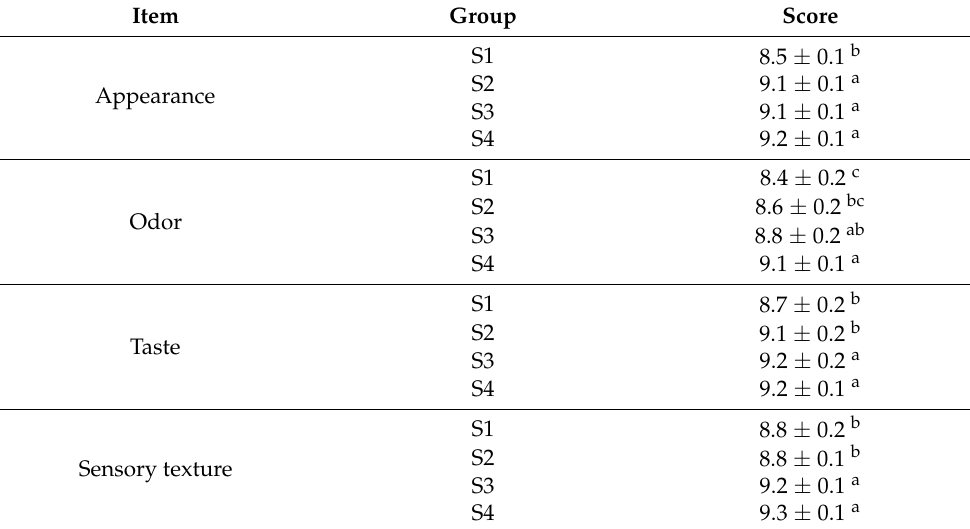
Table 5. Effects of different cooling rates on the sensory evaluation of crucian carp